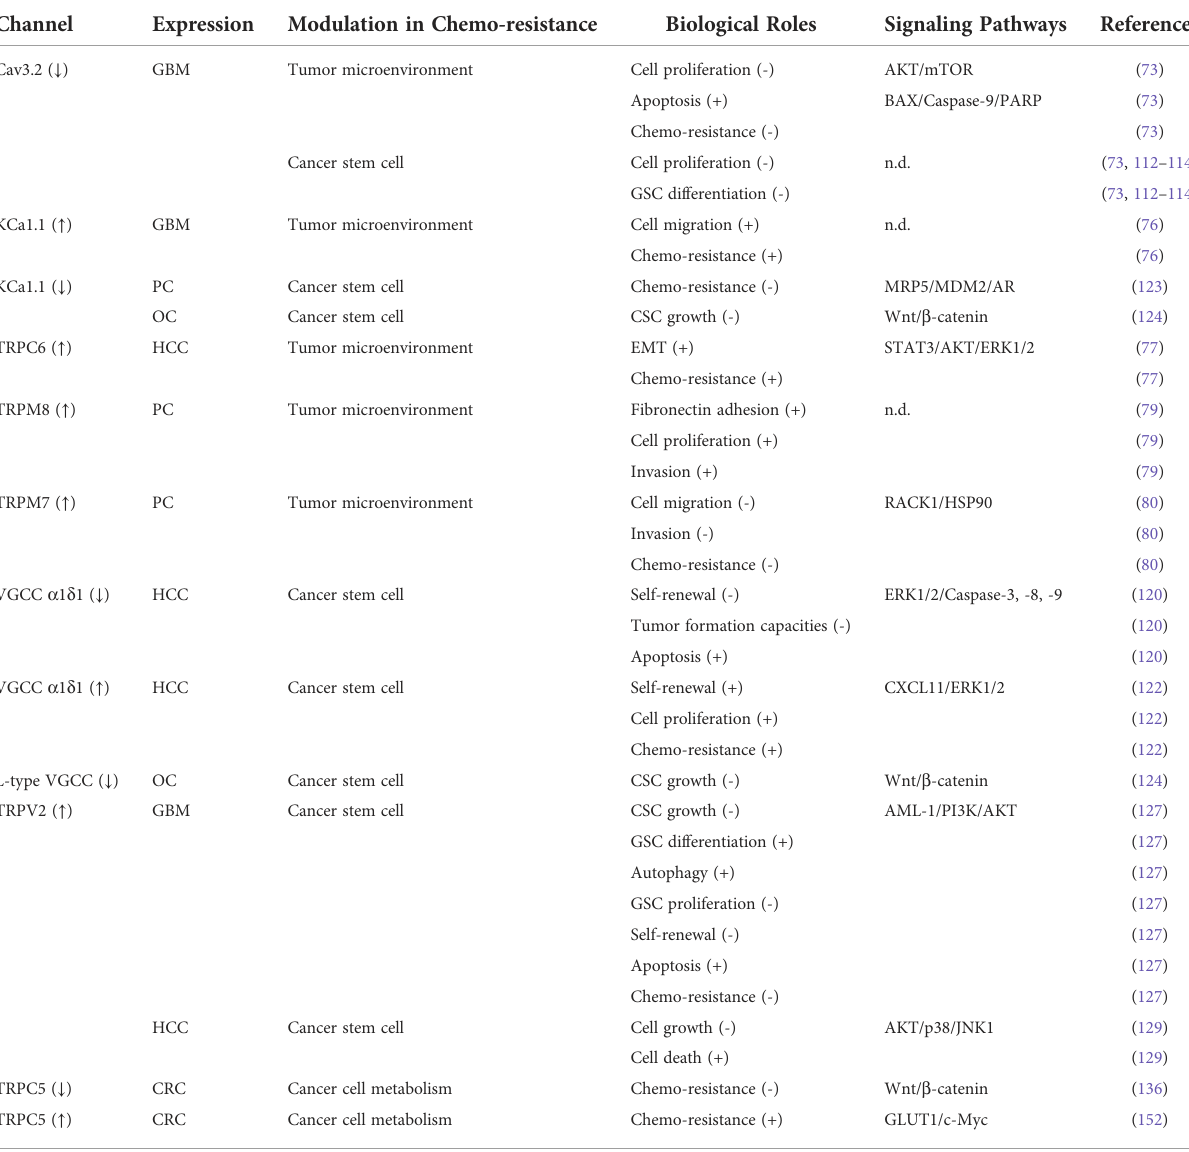
TABLE 1 Ion Channels Modulate in Cancer